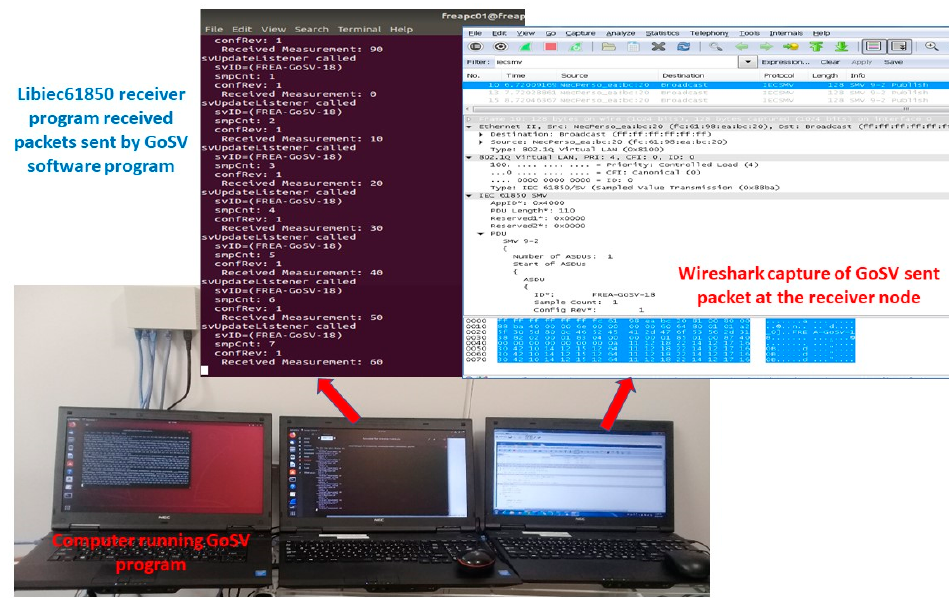
Figure 9. LAN set up to test the developed software ‘GoSV’. Energies 2018 , 11 , x FOR PEER REVIEW